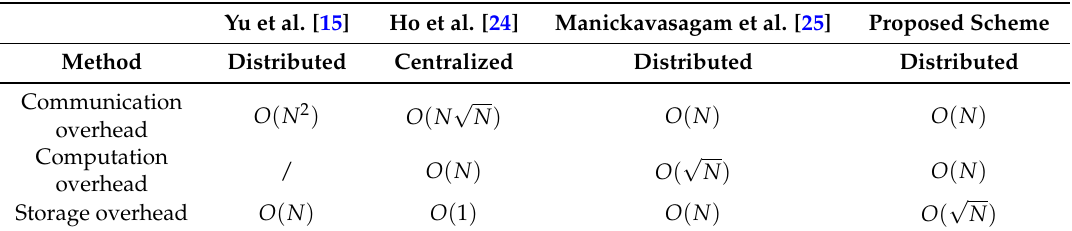
Table 3. Comparison with